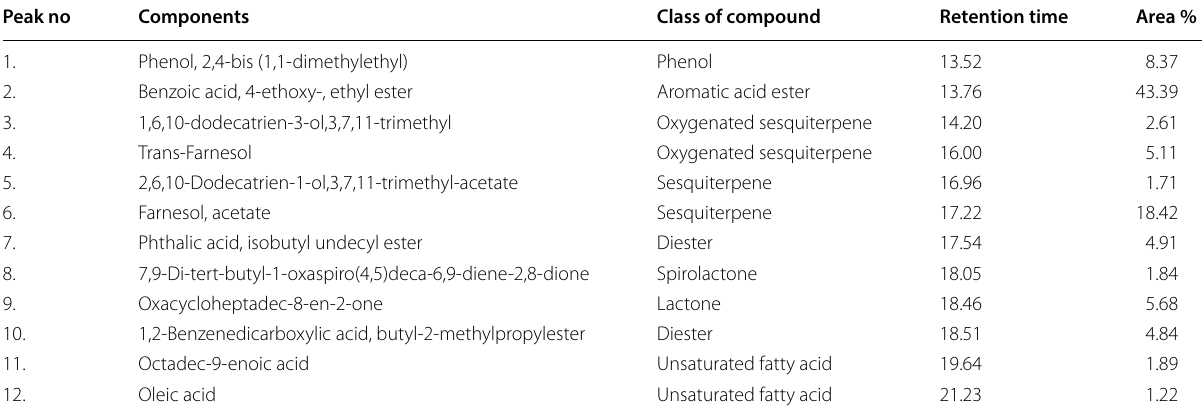
Compound proportions were calculated from the chromatograms obtained on the TG-5MS column. The percentage of the compounds detected in the GC that was calculated based on the relative area of individual compounds to the total area of the components identified from the extract